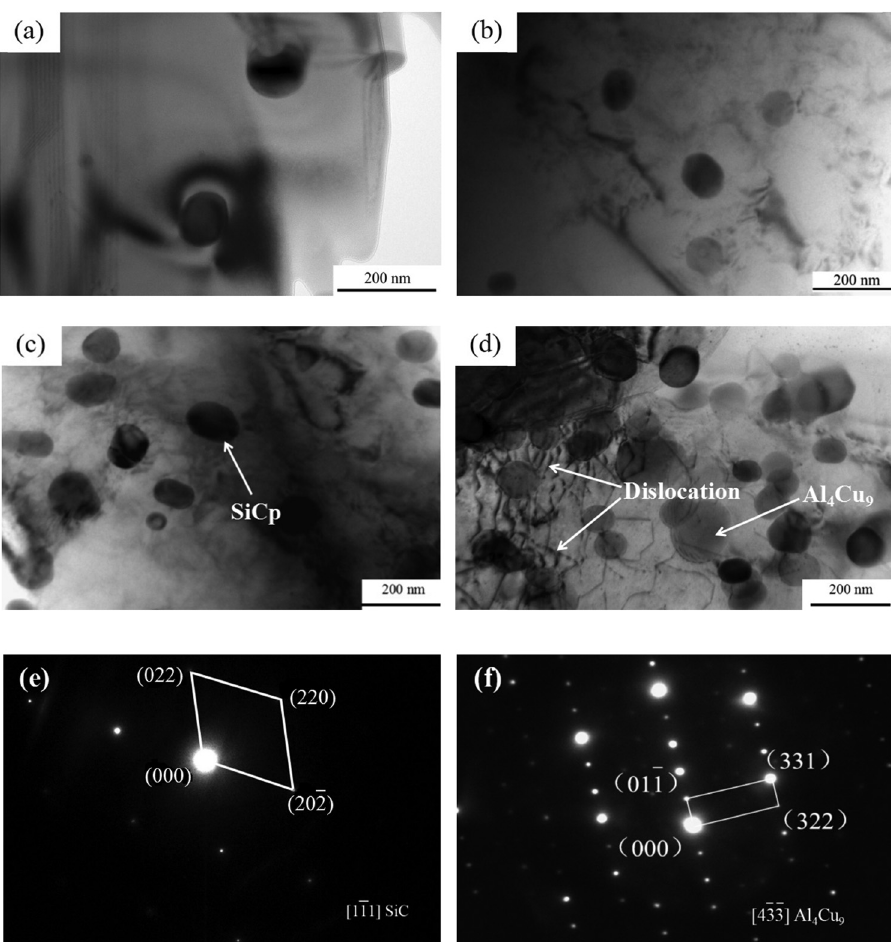
Figure 3: TEM images of composites with di ff erent nano - SiCp volume fraction: ( a ) 1% SiCp, ( b ) 2% SiCp, ( c ) 3% SiCp, ( d ) 4% SiCp, ( e ) di ff raction patterns of SiC, and ( f ) di ff raction patterns of Al 4 Cu 9 .